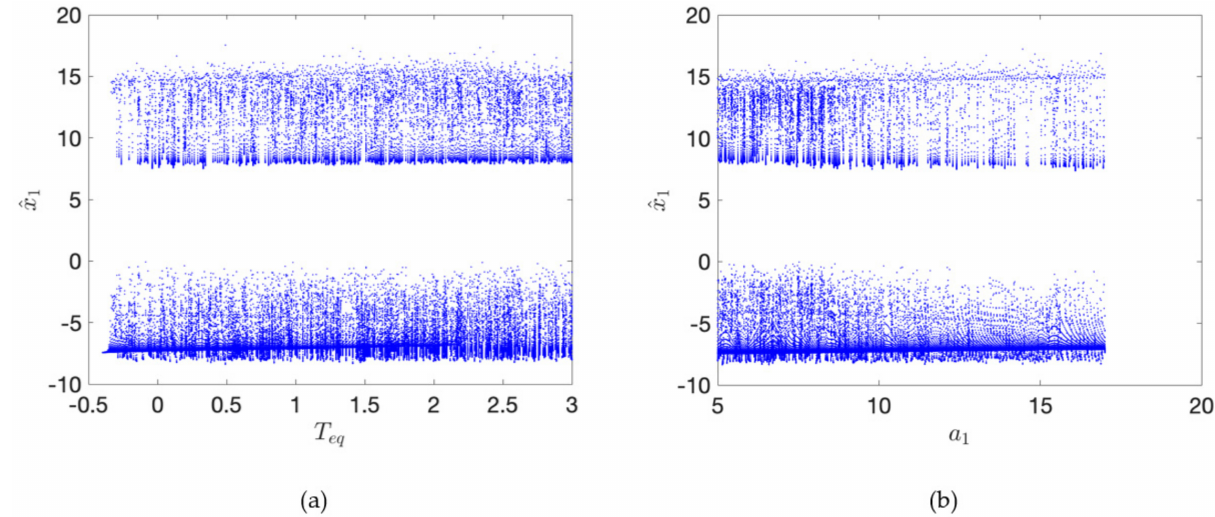
Figure 3. Bifurcations diagrams of System (44) with q = 0.9. ( a ) for T eq with a 1 = 10, ( b ) for a 1 with T eq = 0.